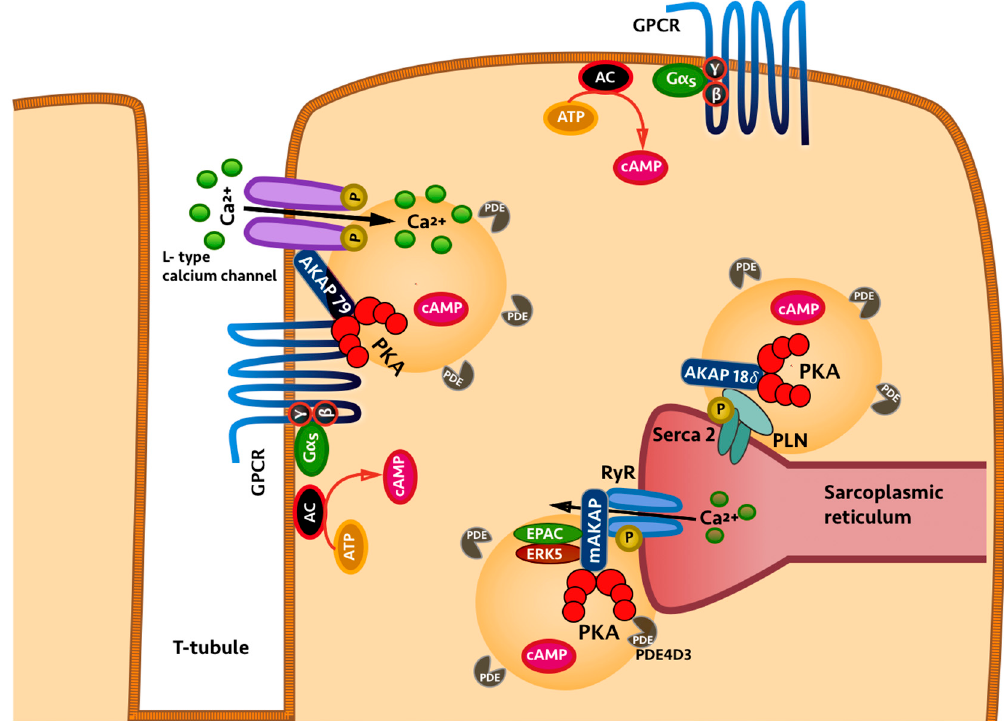
Figure 1. Compartmentalised adenosine 3 ′ -5 ′ -cyclic monophosphate (cAMP) signalling by AKAPs (A kinase anchoring proteins) and phosphodiesterases (PDEs) and intracellular distribution of three AKAP complexes involved in cardiac contractility. AC: adenylyl cyclase; EPAC: GTPase exchange factor directly activated by cAMP; GPCR: G protein-coupled receptor; P: phosphate group; PKA: protein kinase A; PLN: Phospholamban; RyR: Ryanodine receptor. Red shaded areas indicate distinct cAMP pools generated by an AC anchored at the plasma membrane and activated by a GPCR exposed to the extracellular space. Black arrows indicate Ca 2+ flow. Red arrows indicate synthesis of cAMP. PKA anchored to AKAPs and the activity of PDEs contribute to spatial regulation of cAMP and specific downstream physiological effect, as selective PKA phosphorylates the target that is contained within the specific microdomain.